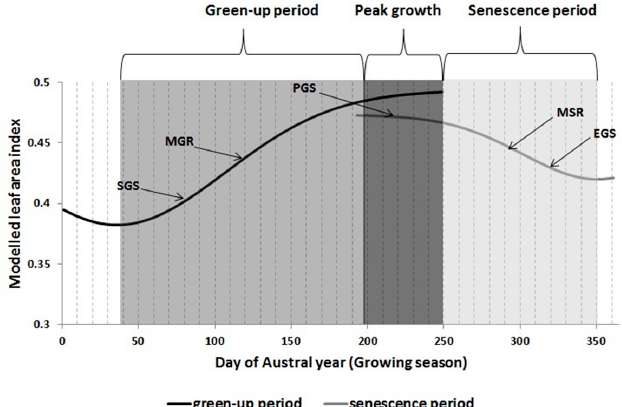
Figure 5. Land surface phenological metrics resulting from fitting an inverted Gaussian model to the LAI austral year curve on the green-up and senescence periods of the vegetated landscape. SGS, MGR, PGS, MSR and EGS denote dates corresponding to start, maximum growing rate, peak growth, maximum senescing rate and end of growing season, respectively.